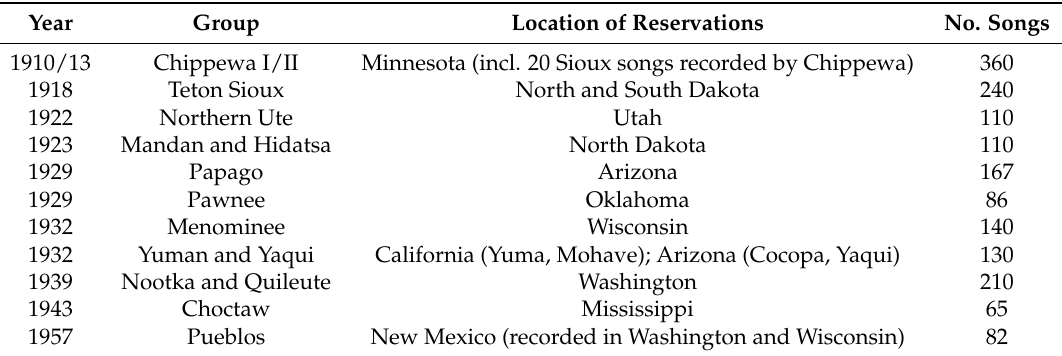
Table 1. Analysis corpus based on Densmore’s publications (with year of